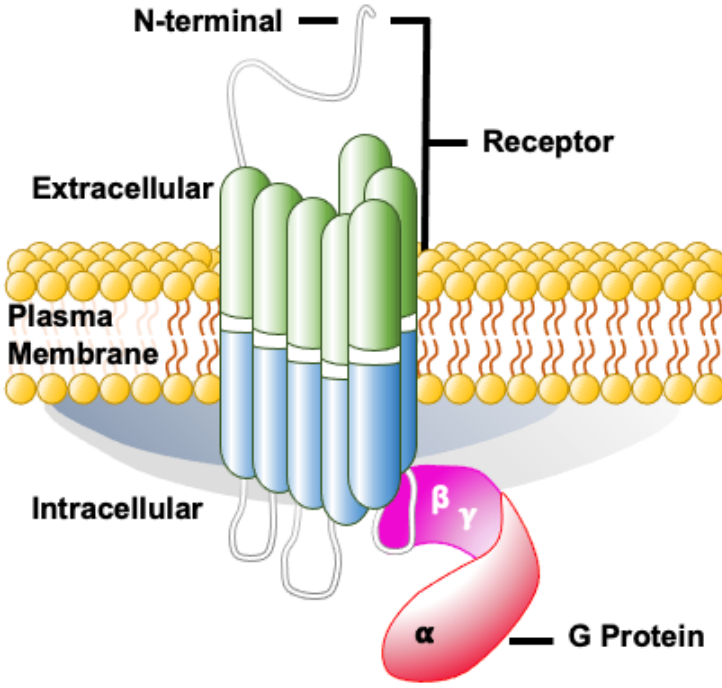
Figure 1. Illustration of somatostatin receptor.